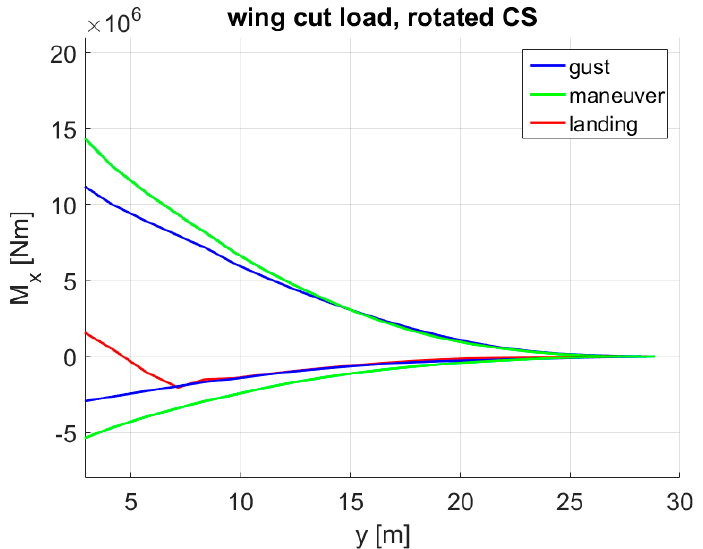
Figure 31. Bending moment envelope with enhanced MLA + GLA.